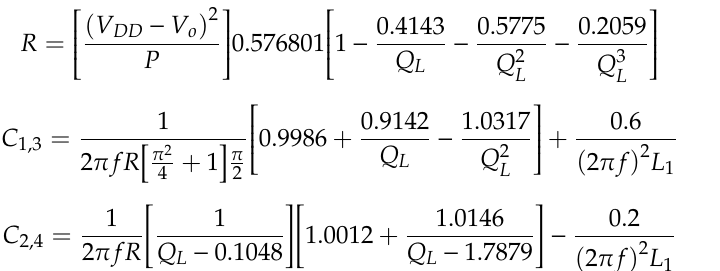
Table 1. Component values for the PA including the inductor.